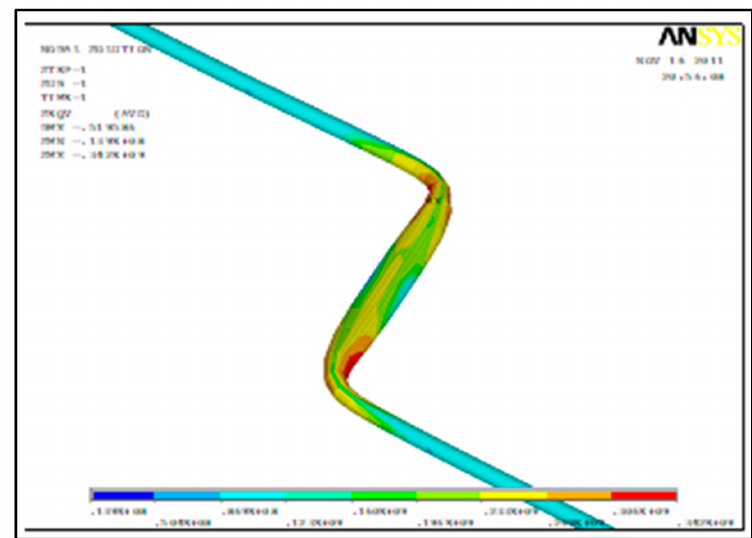
Figure 7. Stress cloud diagram of the pipe section near the fault.